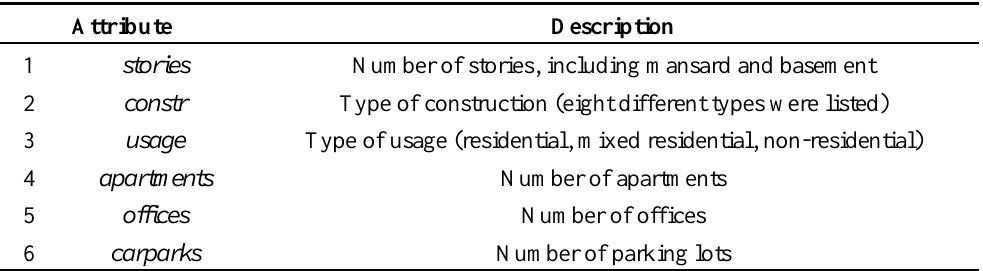
Table 1. Attributes used to constrain the logistic regression.